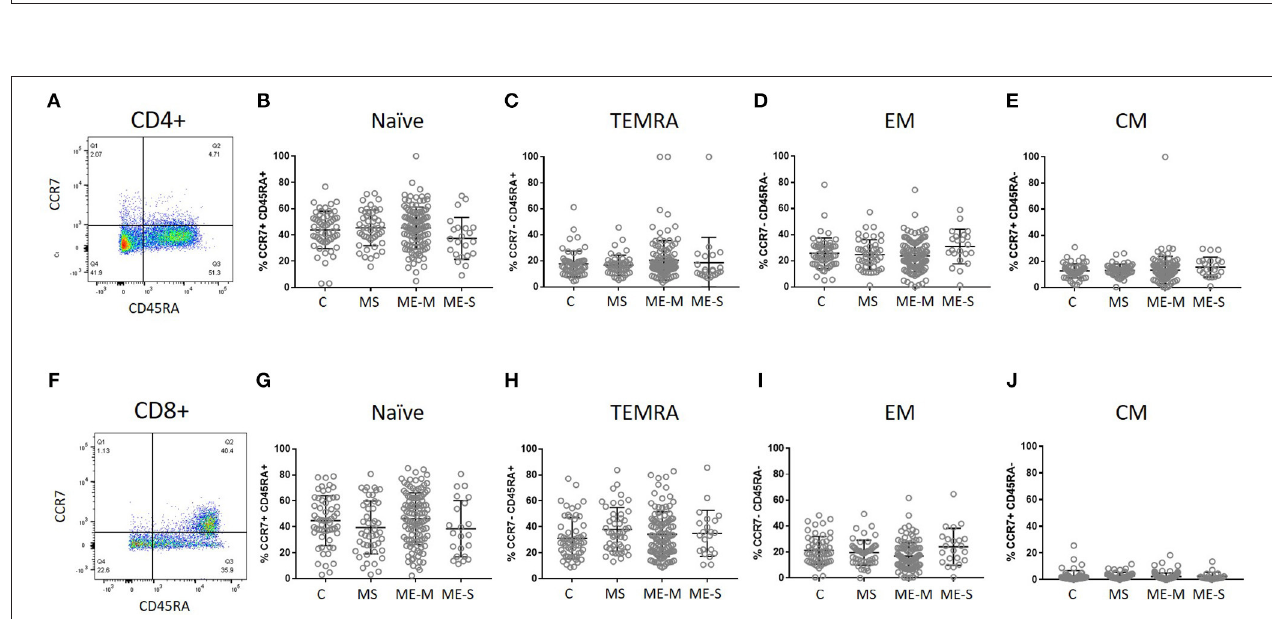
FIGURE 4 | Delineation of T cell naïve and memory cells in ME/CFS and MS patients and controls. CD4 + (A–E) and CD8 + (F–J) T cells were analysed for CD45RA and CCR7 co-expression to quantify proportions which were naïve CD45RA + CCR7 + (B,G) , effector memory RA (TEMRA) CD45RA + CCR7 − (C,H) , effector memory CD45RA − CCR7 − (D,I) or central memory CD45RA − CCR7 + T cells. The bars show the Mean and SD. Data are from C ( n = 56), MS ( n = 46), ME-M ( n = 120), and ME-S ( n = 21). Clinical groups were compared by Kruskal-Wallis test for non-parametric data.